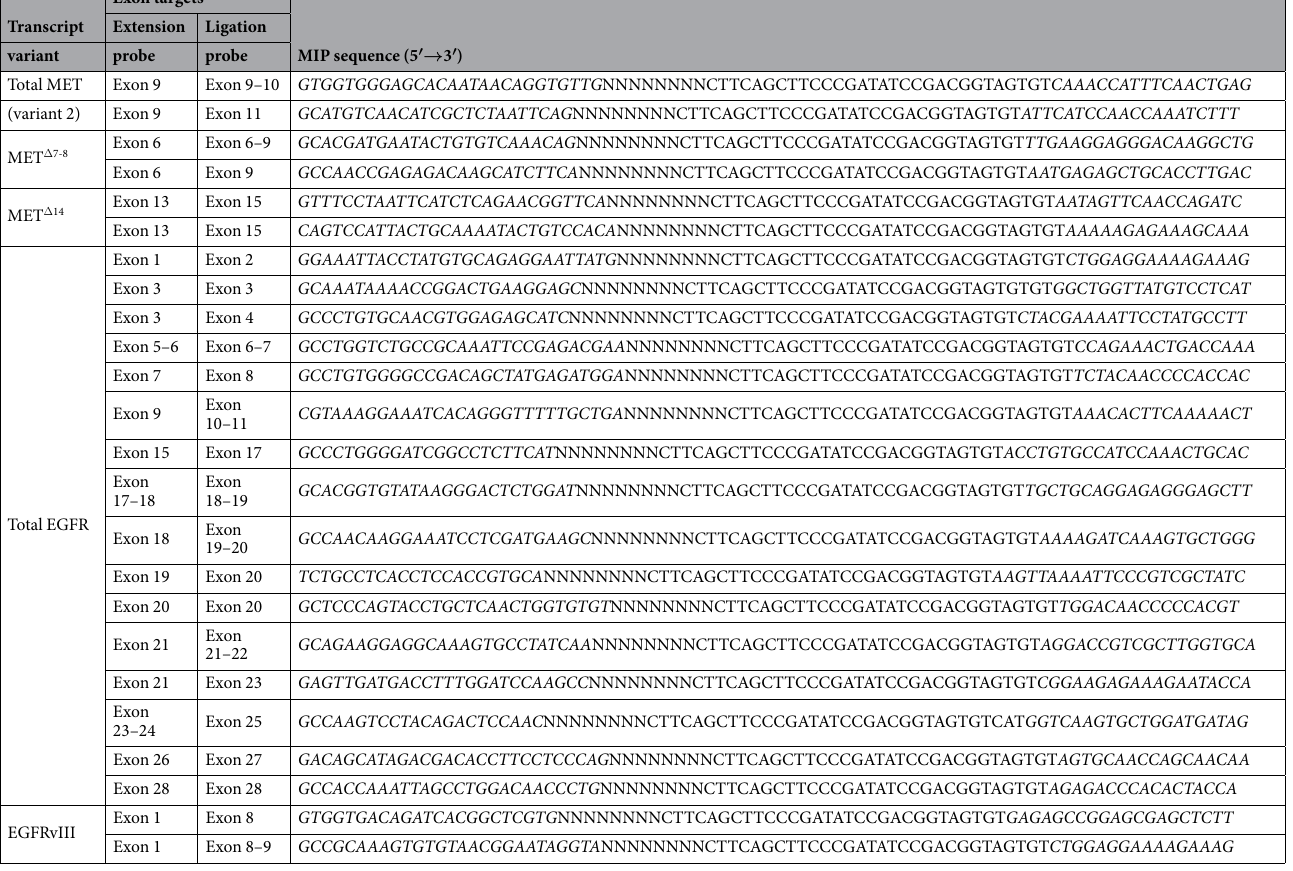
Nucleotide sequences (5 ′→ 3 ′ )